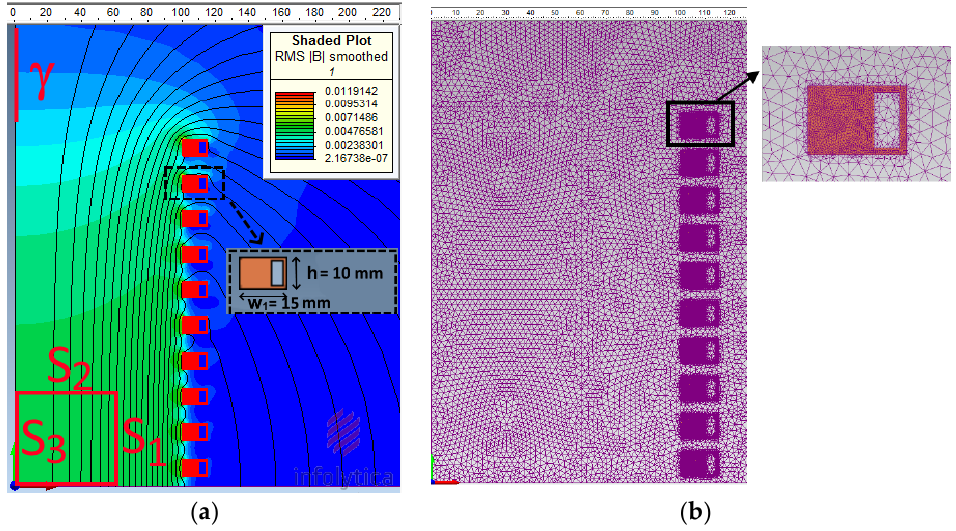
Figure 3. Geometry, controlled regions, and magnetic flux lines ( a ); discretized domain ( b ).